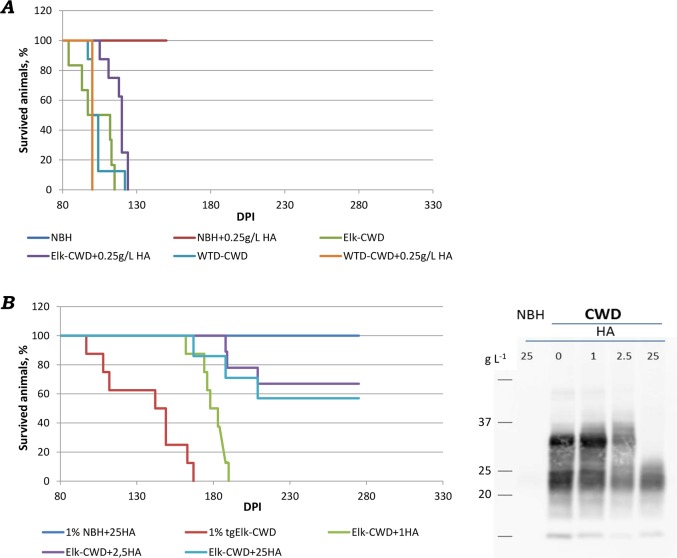
Infectivity bioassays.(A) Intracerebral inoculation into tgElk mice. Mice inoculated with 0.16% Elk-PrPCWD alone exhibited an incubation time of 102±13 dpi; the same amount of PrPCWD with HA presented with clinical signs at 118±7 dpi; WTD-CWD inoculum resulted in incubation period 104±8 dpi while mice inoculated with WTD-CWD+HA were CWD-positive at 100 dpi. Mice inoculated with NBH with and without HA remained healthy throughout the course of the experiment. (B) Intraperitoneal inoculation into tgElk mice revealed significant differences between mice inoculated with untreated BH and BH pre-incubated with lowest (1 g L-1) concentration of HA. Half of the mice inoculated with a higher HA concentration showed clinical signs and were euthanized; another half did not show clinical signs. Immunoblot shows inoculum prepared for inoculation: BH (10% Elk-CWD) without and with 1g L-1, 2.5 g L-1 and 25 g L-1 concentrations of HA were incubated overnight.